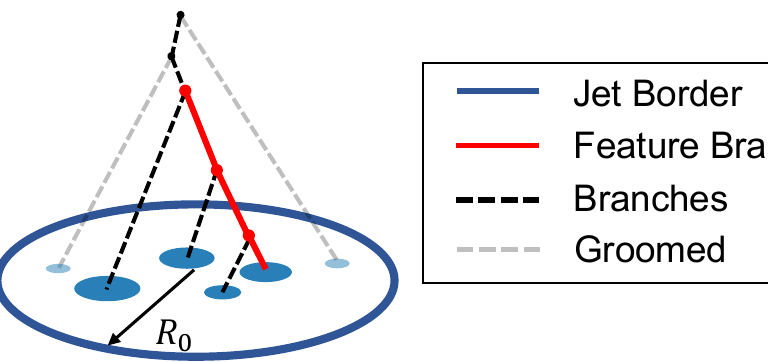
Figure 5 . Jet clustering history with a binary tree